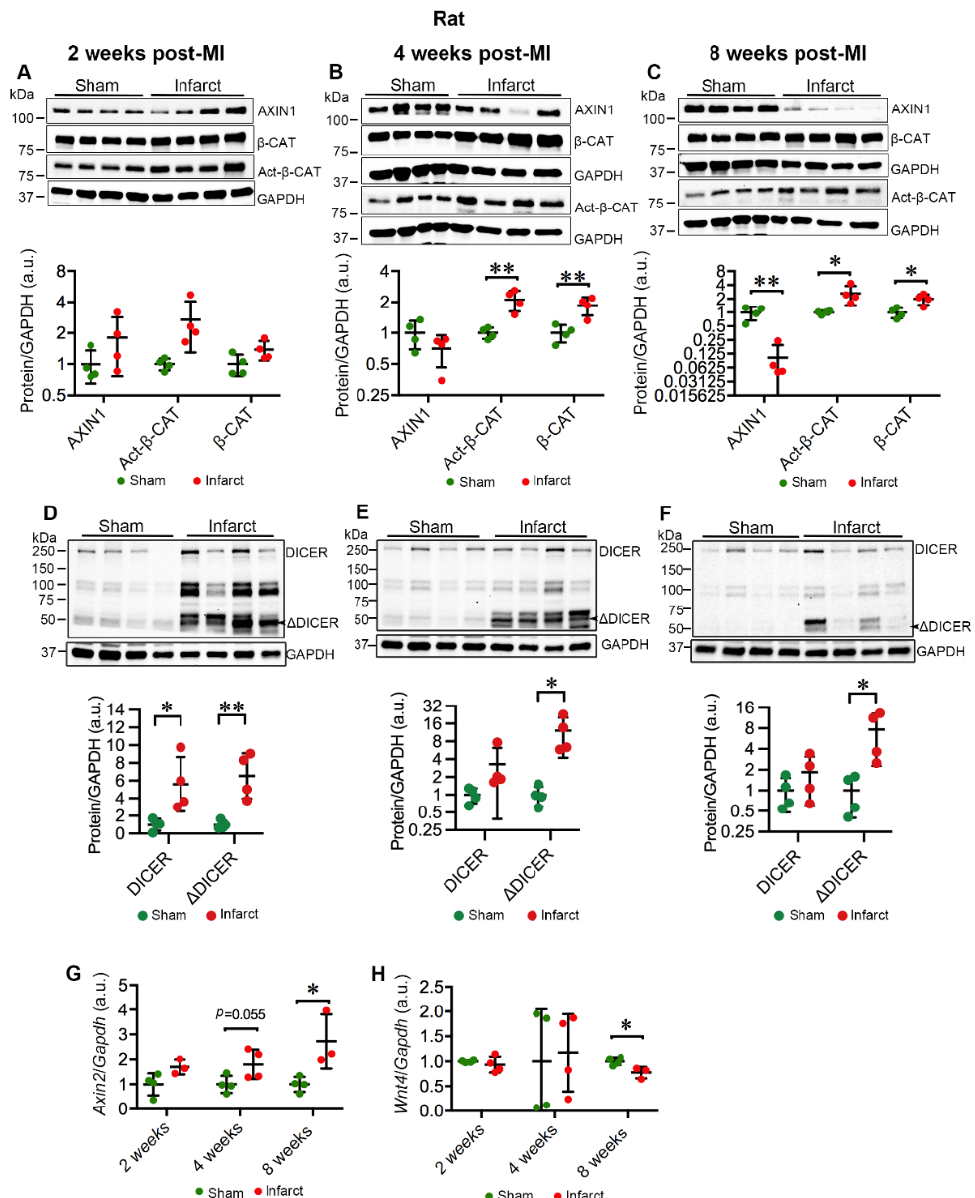
Figure 5. MI destabilizes AXIN1 and activates Wnt/ β -catenin signaling in the infarct area in rat hearts. ( A – C ) Representative immunoblots of AXIN1, total β -catenin ( β -CAT), and active β -catenin (Act- β -CAT) in the infarct area in MI rat hearts and sham-operated controls at 2 ( A ), 4 ( B ), and 8 ( C ) weeks post-MI. ( D – F ) Representative immunoblots of DICER in the infarct area in MI rat hearts and sham-operated controls at 2 ( D ), 4 ( E ), and 8 ( F ) weeks post-MI. The graphs represent quantifications of three replicate blots for the indicated proteins normalized to GAPDH. The results are presented as fold change compared to controls. Sham, n = 4; MI, n = 4. ( G , H ) qRT-PCR analysis of Axin2 ( G ) and Wnt4 ( H ) in the infarct area of MI rats and sham-operated controls. Axin2 : Sham, n = 4; MI 2 and 8 weeks, n = 3; 4 weeks, n = 4; Wnt4 : Sham, n = 4; MI 2 and 4 weeks, n = 4; 8 weeks, n = 3. Data are presented as mean ± SD. Two-sample t -test: * p < 0.05, ** p <